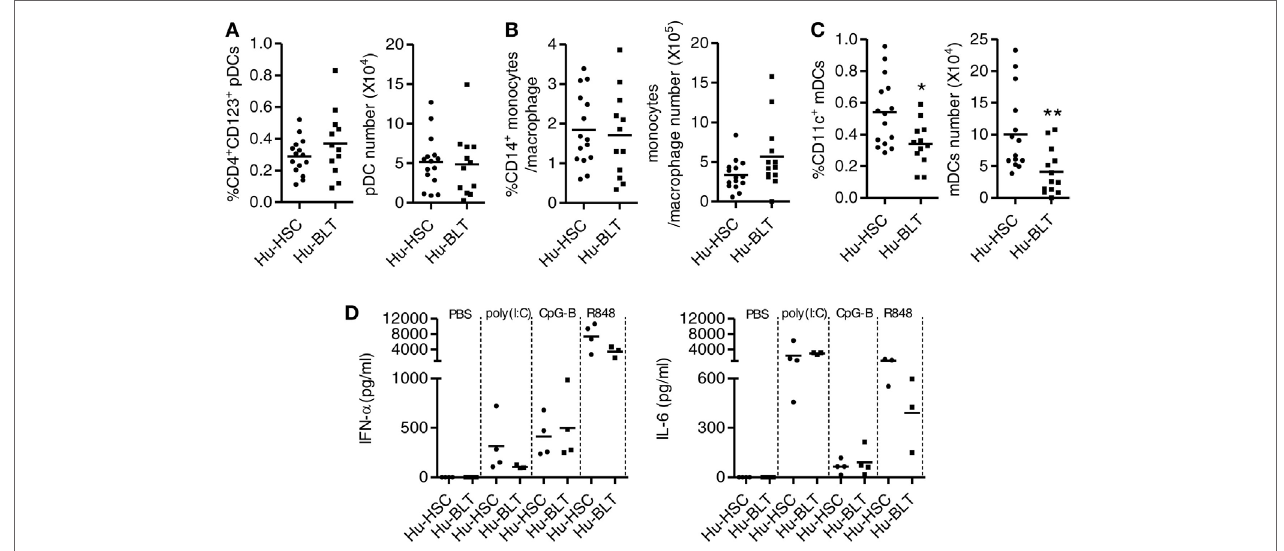
FigUre 4 | Development and function of human innate immune cells from NRG-hu HSC and NRG-hu Thy/HSC mice. NRG-hu HSC and NRG-hu Thy/HSC mice were terminated at 20 weeks after reconstitution. (a–c) Summarized data show percentage and number of total human plasmacytoid dendritic cells (pDCs) (CD3 − CD19 − HLA-DR + CD4 + CD123 + ), monocytes or macrophage (CD3 − CD19 − HLA-DR + CD14 + ), and myeloid dendritic cell (mDC) (CD3 − CD19 − HLA- DR + CD11c + CD14 − ) in spleen. Shown (a–c) are data from n = 15 (NRG-hu HSC) and n = 12 (NRG-hu Thy/HSC) hu-mice per group reconstituted with HSCs ± thymus from same donor. (D) NRG-hu HSC and NRG-hu Thy/HSC mice were injected intraperitoneally with CpG-B (50 μ g/mouse), poly I:C (50 μ g/mouse), R848 20 μ g/mouse, or PBS. Plasma was collected at different time points posttreatment. IFN- α levels in plasma were detected at 24 h after treatment. IL-6 level was detected at 4 h after treatment. Shown (D) are data from three to four mice each group for each treatment conditions. Each dot represents one individual mouse; bars indicate mean (* P < 0.05 and ** P < 0.01, by unpaired, two-tailed Student’s t